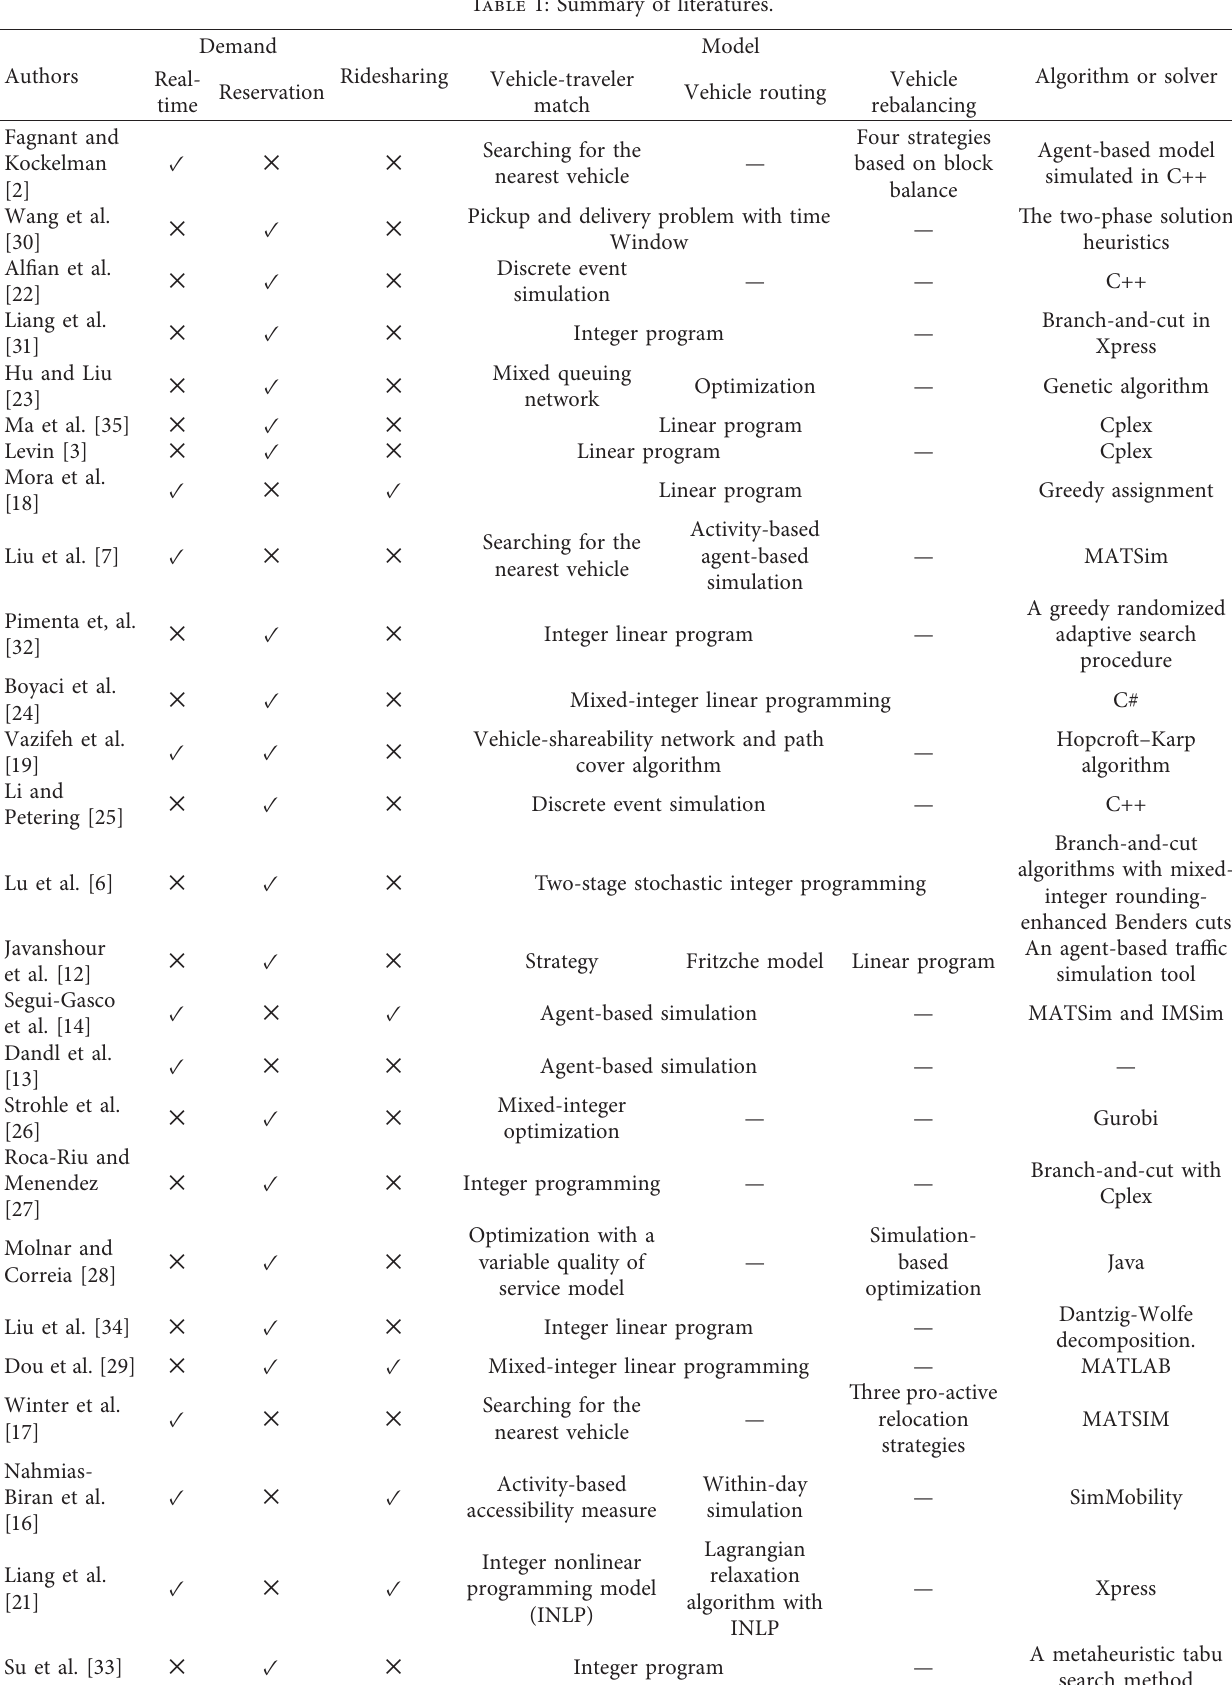
Table 1: Summary of